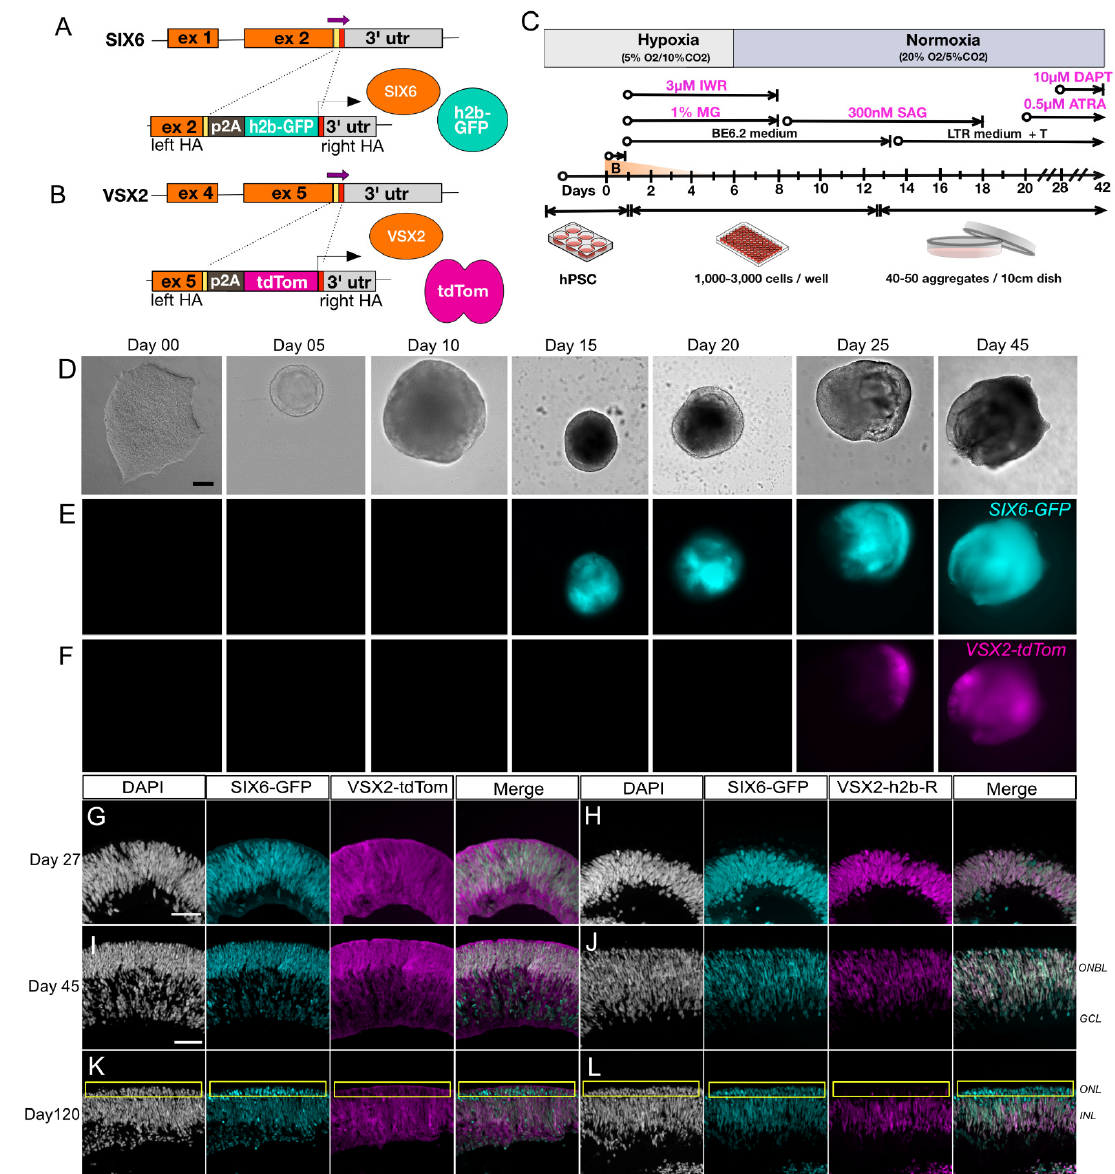
Figure 1. Generation and characterization of a dual fluorescent human PSC reporter line for visual- ization of retinal differentiation. ( A ) A PSC line with a single SIX6 -h2b-GFP reporter was ( B ) further modified with a VSX2 -p2A-tdTomato reporter cassette. ( C ) Graphical protocol for differentiation of retinal organoids adapted from Wahlin et al., 2017. Representative images for differentiating SIX6 - GFP/ VSX2 -tdTomato PSCs organoids in brightfield ( D ) and ( E , F ) SIX6 -GFP and VSX2 -tdTomato fluorescence visualized up to differentiation day 45. Organoids at day 15 are smaller than at day 10 due to manual cutting on day 10. Images are separate organoids and are not tracked over time. ( G – L ) Cross sections of organoids from day 27 ( G , H ), day 45 ( I , J ), and day 120 ( K , L ) show nuclear GFP expression throughout the organoid and tdTomato expression becoming restricted over time. Panels ( G , I , K ) represent cytoplasmic VSX2 -tdTomato reporter expression, while panels ( H , J , L ) represent nu- clear VSX2 -mRuby3. A yellow box ( K , L ) indicates the outer nuclear layer. Scale bars ( D – F ) = 100 µ m; VSX2 -tdTom = VSX2 -tdTomato, VSX2 -h2b-R = VSX2 -h2b-mRuby3; Scale bar ( G – L ) = 50 µ